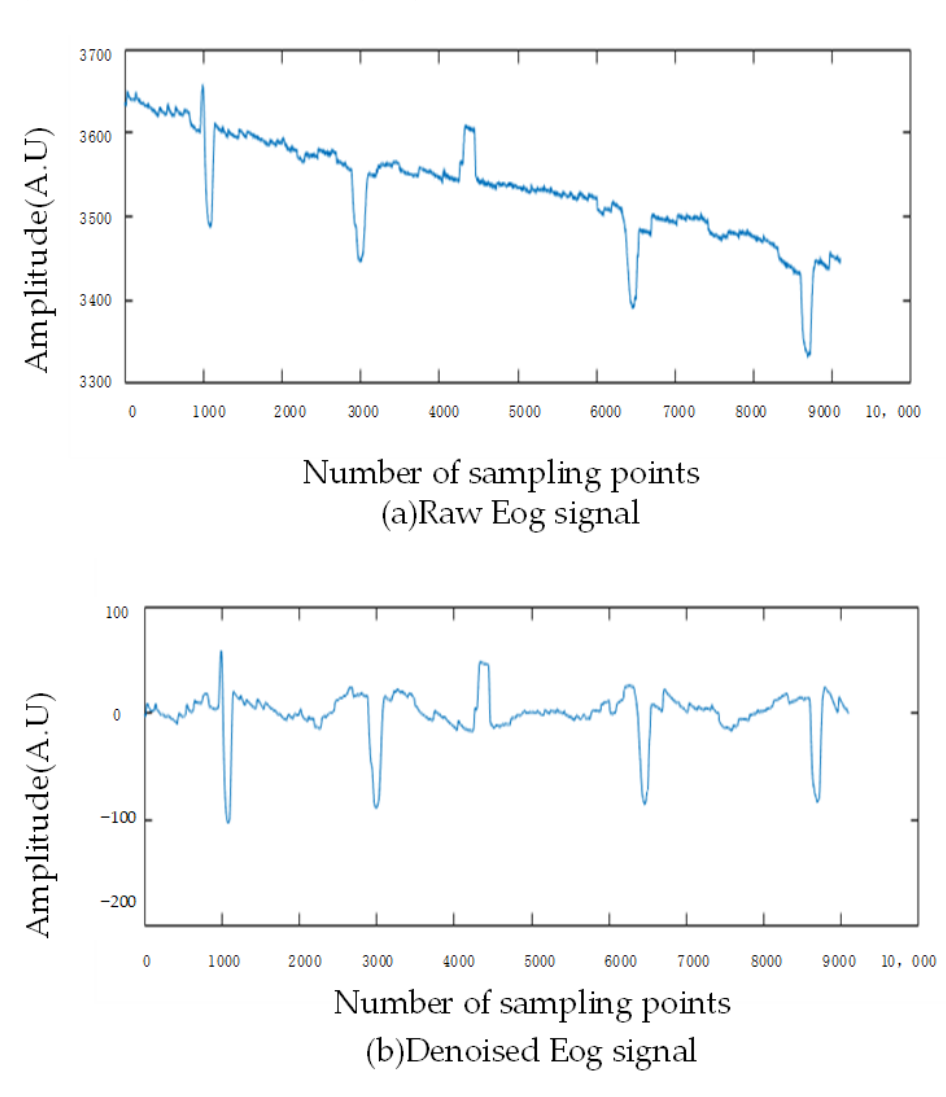
Figure 7. Comparison of raw EOG signal and processed EOG signal.